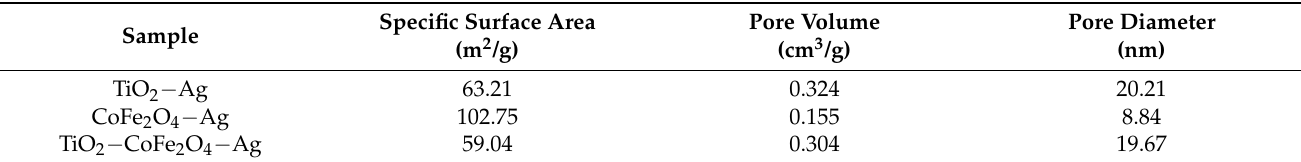
Table 1. Physical properties of TiO 2 − Ag, CoFe 2 O 4 − Ag, and TiO 2 − CoFe 2 O 4 − Ag. Specific Surface Sample